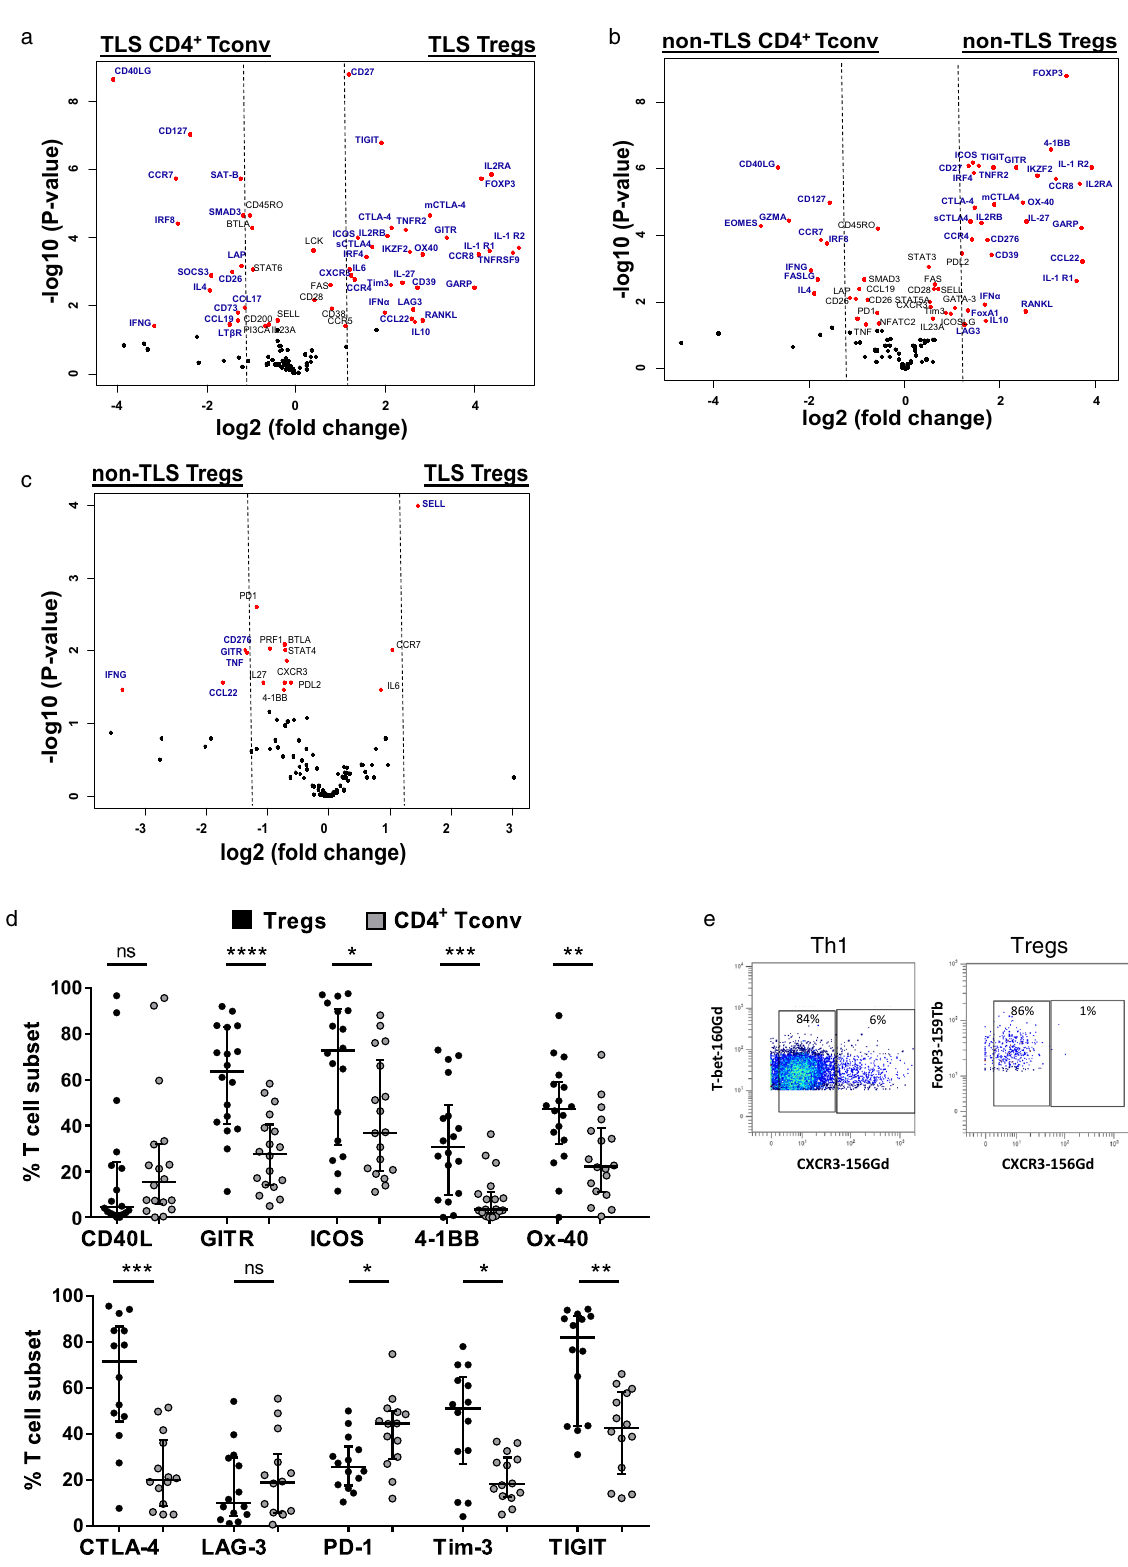
Fig. 5. Sensitivity analysis with Cox Lasso approach led to identical variable selection. In conclusion on one hand, Tregs including TLS-Tregs and, on the other hand, TLS-DC and CD8 + T cells have a dual impact on the outcome of NSCLC patients. And the combination of the three parameters provides a strong prognostic indicator